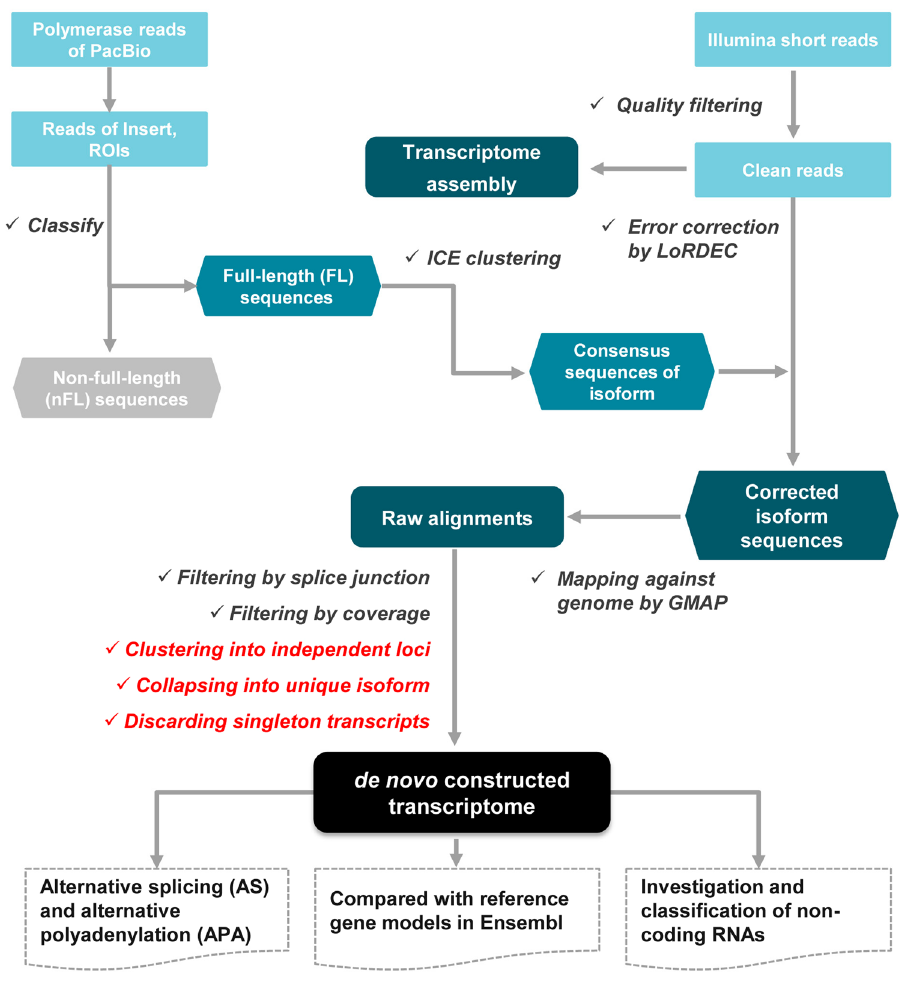
Figure 5. Pipeline of bioinformatic analyses. The processing steps are individually ticked, and among which the clustering, collapsing and filtering of GMAP alignments were conducted using our in-house scripts (in